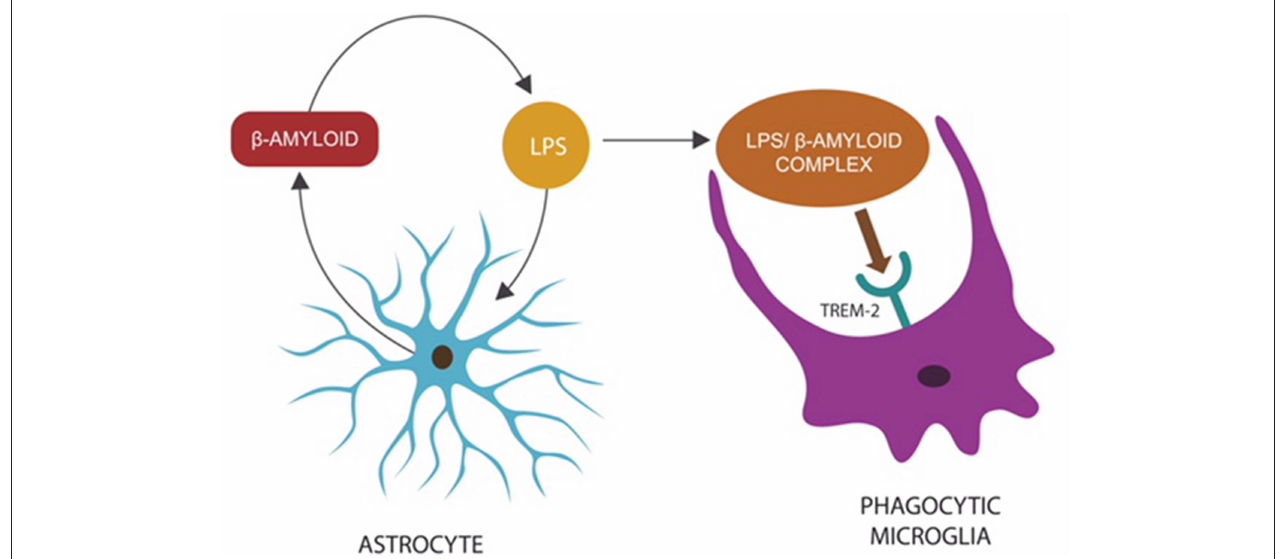
FIGURE 1 | Microbes or LPS that access the CNS comprise “danger” signals, triggering an innate immune response: the release of β -amyloid by astrocytes to opsonize “the intruder,” preparing it for phagocytosis (Zhan et al., 2018). The LPS– β -amyloid complex is subsequently engulfed by microglia, eliminating the “danger.” Microglial TREM-2, a β -amyloid receptor, initiates phagocytosis by binding the entire complex ( Zhao et al., 2018). This mechanism may explain the reason TREM-2 genetic variants (with loss of function) present with impaired phagocytosis and β -amyloid accumulation ( Guerreiro et al., 2012; Zhan et al.,